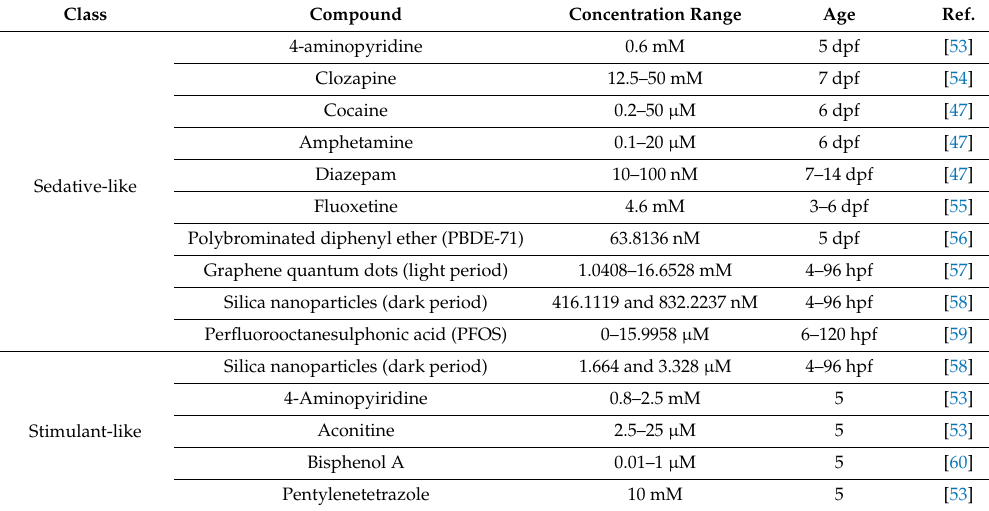
Table 1. Examples of agents with sedative-like and stimulant-like e ff ects on larval locomotor behavior. Sedative-like e ff ects represent decreased swimming speed and / or distance, in either a light or dark period, while stimulant-like e ff ects represent increased swimming speed and / or distance. Concentrations have been standardized to molarity to facilitate comparisons. hpf = hours post-fertilization; dpf = days